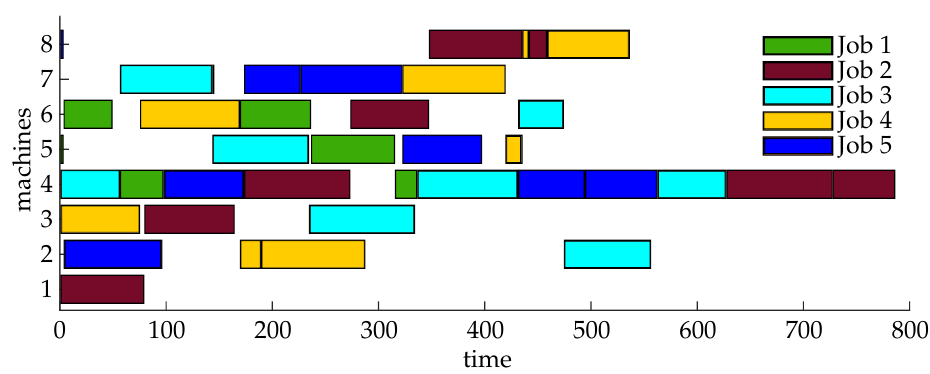
Figure 5. Gantt chart of the closed loop schedule for the medium sized scheduling problem “ mops1.json ” [37], resulting from the application of the MPC